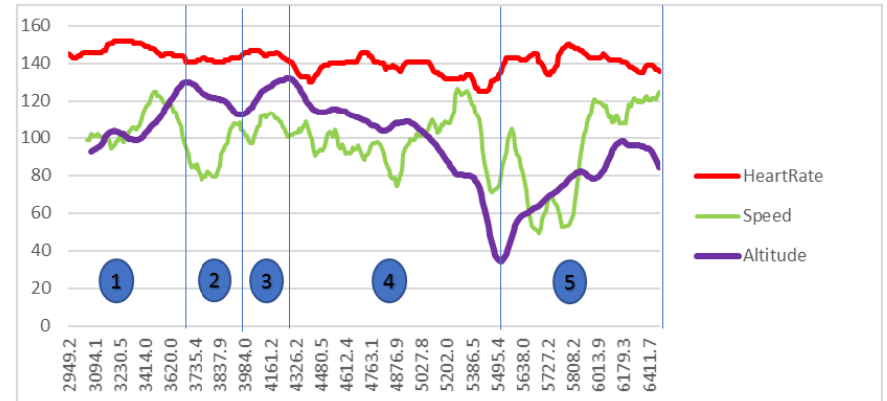
Figure 2. Movement parameter profiles of section 5 (forest) in Figure 4.